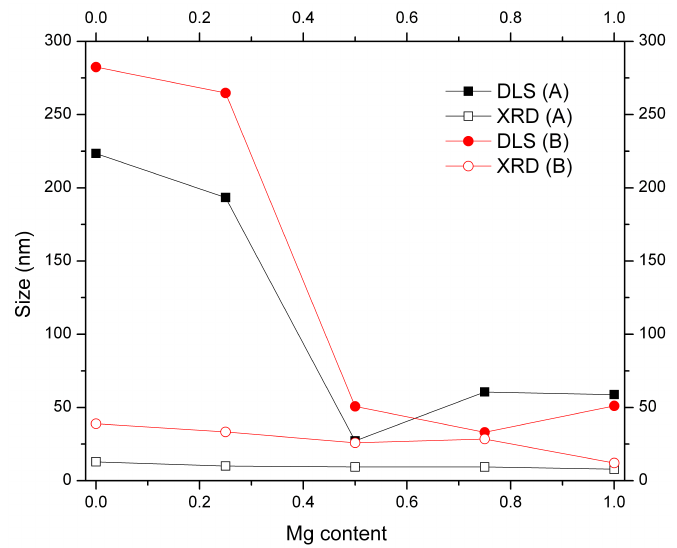
Figure 4. Hydrodynamic size (DLS) and average crystalline domain size (XRD) for all samples’ trends with nominal Mg content variation.